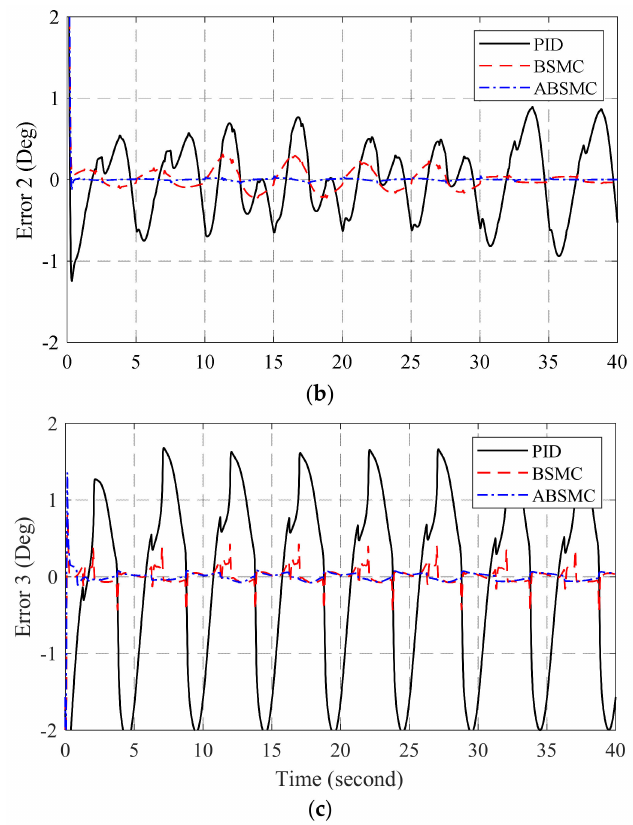
Figure 5. Joint errors of PID, BSMC, and ABSMC in ( a ) joint 1, ( b ) joint 2, ( c ) joint 3.